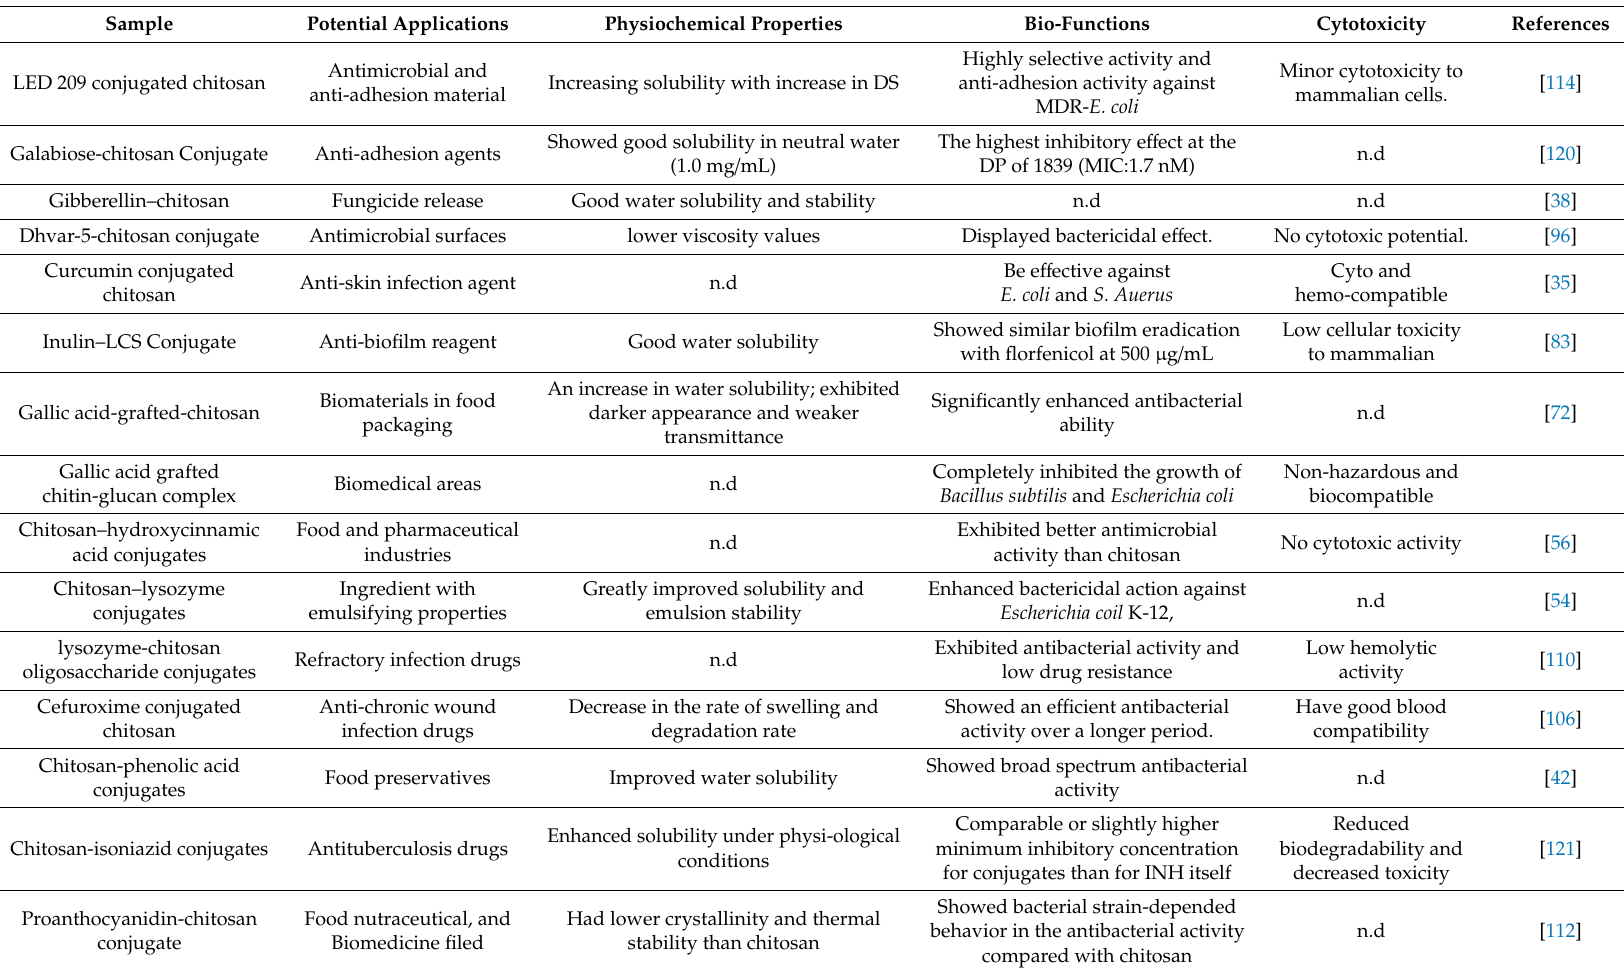
Table 3. Physicochemical properties, bio-functions, cytoxicity and potential applications of the typical chitosan conjugates